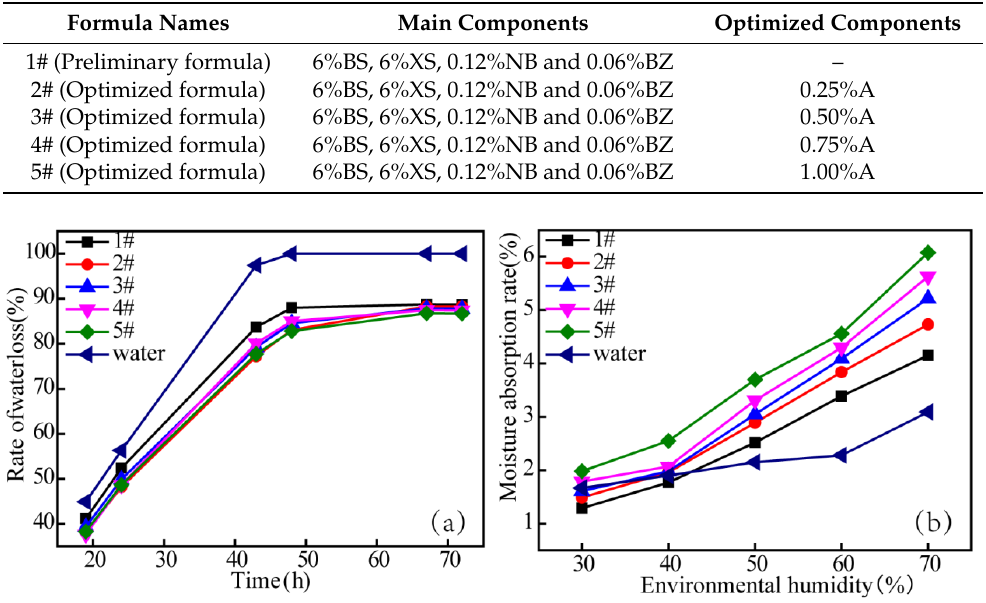
Figure 5. ( a ) Variation curves of water loss rate of samples; ( b ) variation curves of the hygroscopicity rate of samples with moisture.